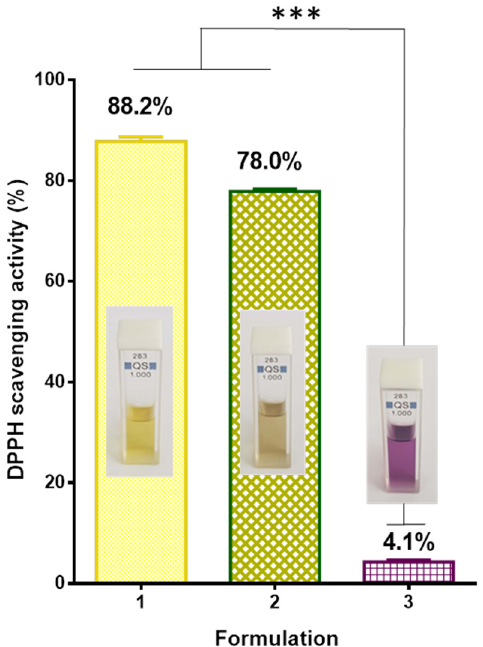
Figure 5. Antioxidant activity: 1—ethanol solution of the P. oleracea crude extract; 2—PLA/ P. oleracea mat; 3—PLA mat and inset—digital images of 1—DPPH solution in the presence of the P. oleracea crude extract; 2—DPPH solution in the presence of a PLA/ P. oleracea mat; and 3—DPPH solution in the presence of a PLA mat. *** p < 0.001.